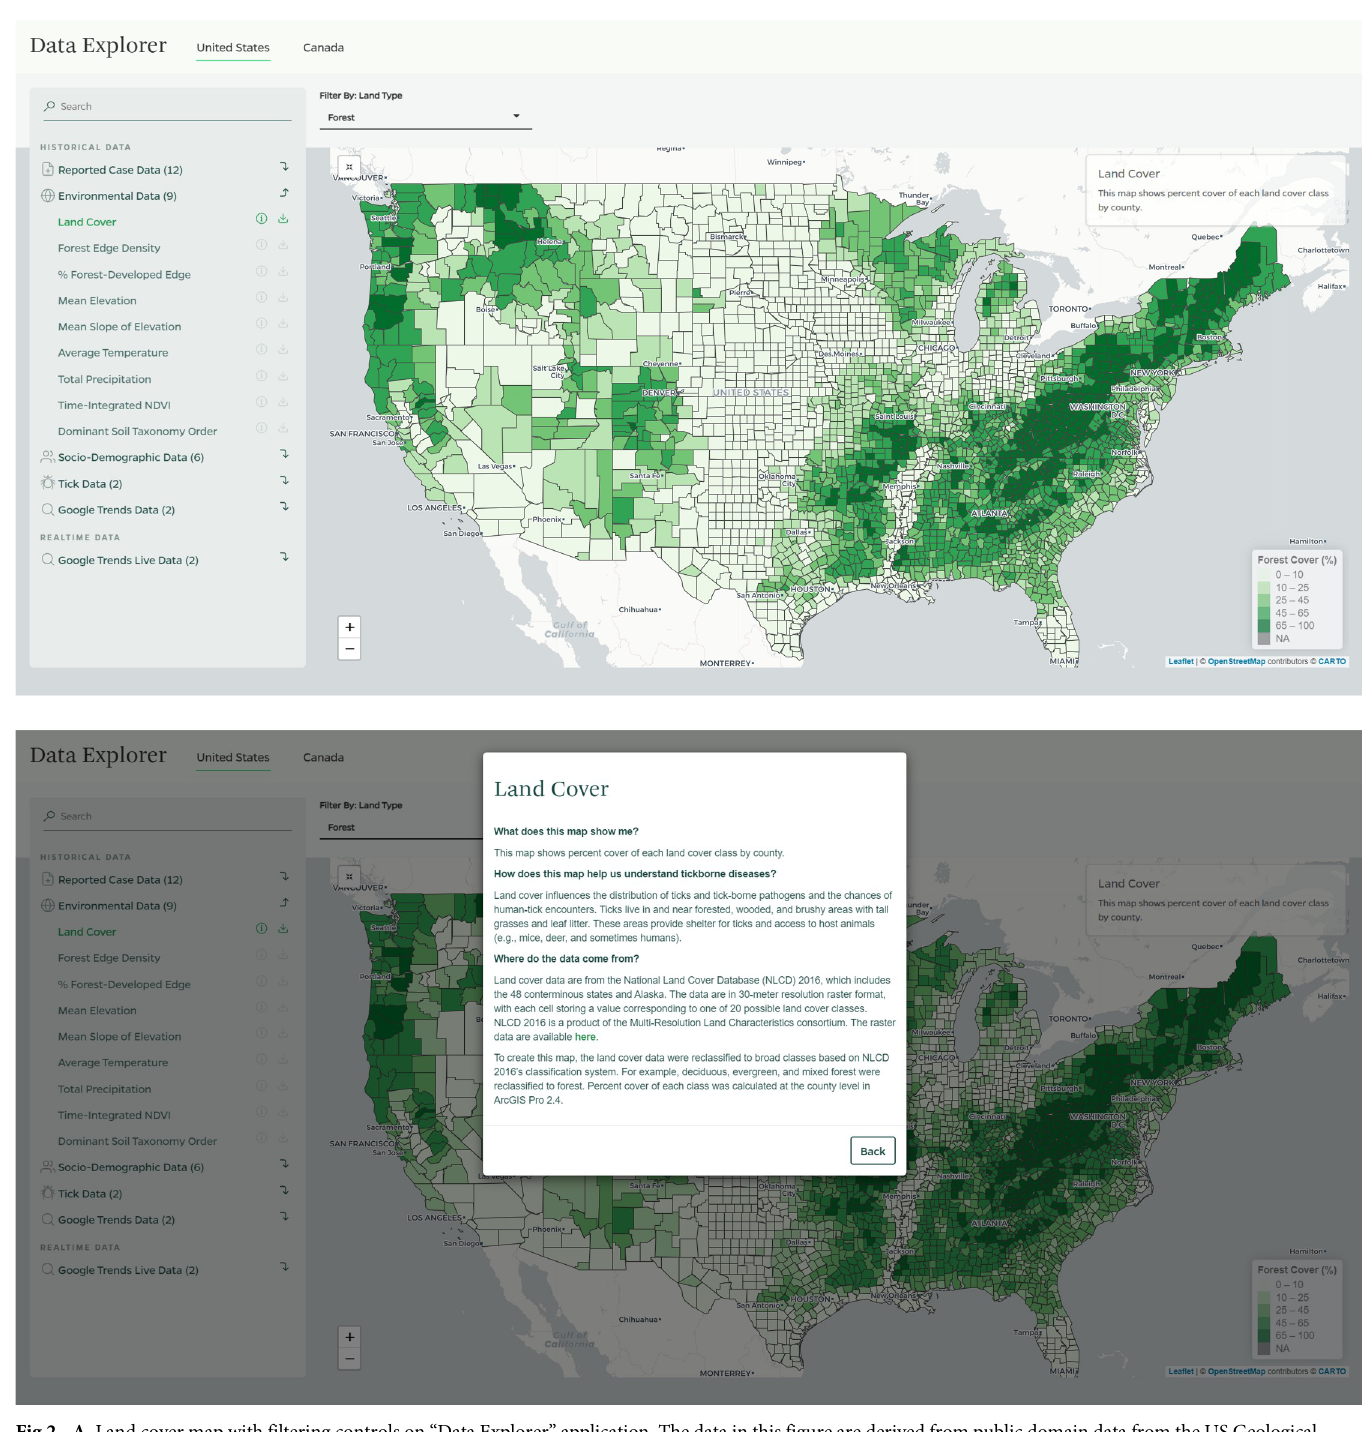
Fig 2. A. Land cover map with filtering controls on “Data Explorer” application. The data in this figure are derived from public domain data from the US Geological Survey. Map tiles are reprinted under a CC BY license, with permission from CARTO, original copyright 2021. CARTO map tiles contain information from OpenStreetMap and OpenStreetMap Foundation, which is made available under the Open Database License. B. Land cover map with popup window on “Data Explorer” application. The data in this figure are derived from public domain data from the US Geological Survey. Map tiles are reprinted under a CC BY license, with permission from CARTO, original copyright 2021. CARTO map tiles contain information from OpenStreetMap and OpenStreetMap Foundation, which is made available under the Open Database License.